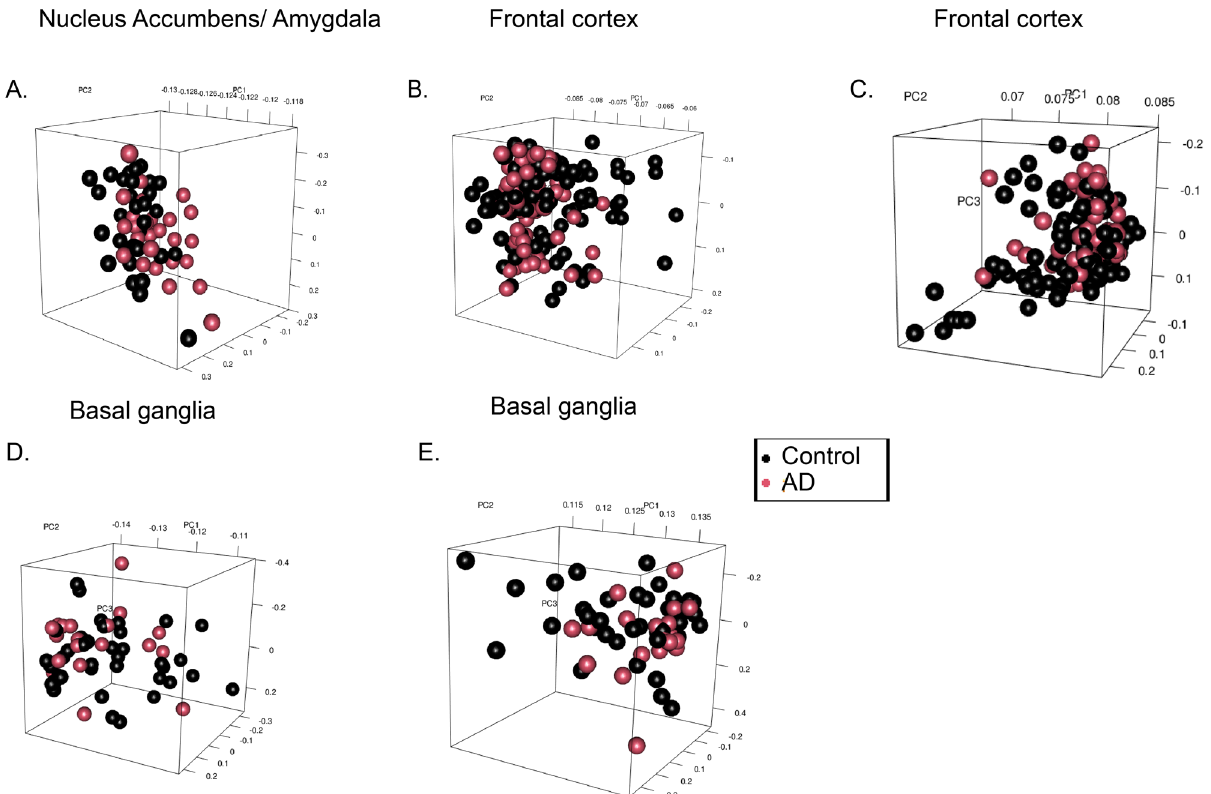
Figure 7 . Principal component analysis on AD patients data. Principal Component Analysis of the controls and the three platforms that make up dataset GSE84422. Details of the platforms and patient data can be found in table 1. ( A ) Represents the data derived from the nucleus accumbens and amygdala. This shows some clustering in the negative direction of the PC1 axis in which both the control and AD subject group seem to cluster together within the same area on the axis. AD patients data, however, spread out more and some subject data can be seen on the positive end of the PC1 axis meaning there is more variability in the subject data. ( B , C ) represents the frontal cortex data both plots represent clusters of data on opposite ends of the PC1 axis but both contain subject data that is clustered together and show some variability among control groups on the PC2 axis. Figures 7D,E represents the basal ganglia subject data which displays more variability in Fig. 7D with no clear clusters. However, ( E ) depicts clusters on the positive end of the PC1 plot and towards the negative end of the PC2